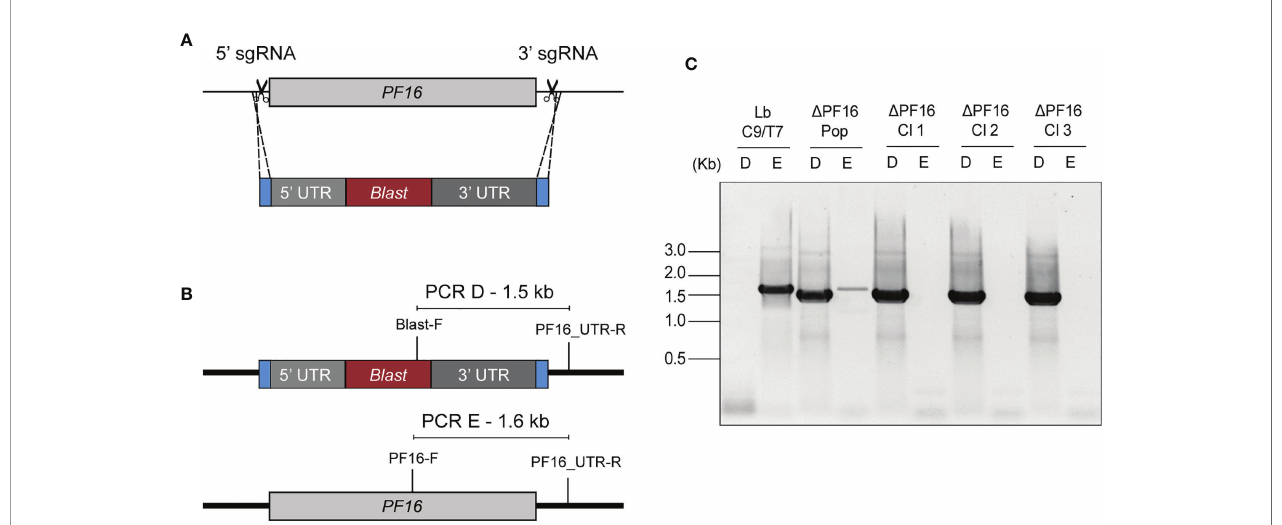
FIGURE 4 | Schematic representation of the strategy used for PF16 knockout in Lb C9/T7 and for PCR screen of transfectants. (A) Two sgRNAs, one at the 5 ′ end and the other at the 3 ′ end of the CDS (scissors), were used to direct Cas9 for the complete removal of PF16 CDS. A donor DNA containing a blastidicin resistance marker (red) and a 30-nt homology arm at each end (blue) were also delivered to mediate a double-strand break repair. (B) Two PCRs (PCR-D and PCR-E) were performed in order to screen for the presence or absence of PF16 (PCR-E) and blasticidin resistance marker (PCR-D) in the parental line (Lb C9/T7), in the transfectant population ( D PF16-Pop), and in the clones D PF16 Cl1 to 3. (C) Electrophoresis in 1% agarose gel shows ampli fi cation of a 1.6-kb fragment, relative to the presence of PF16 CDS (E), only in the parental line (Lb C9/T7) and in the non-cloned population ( D